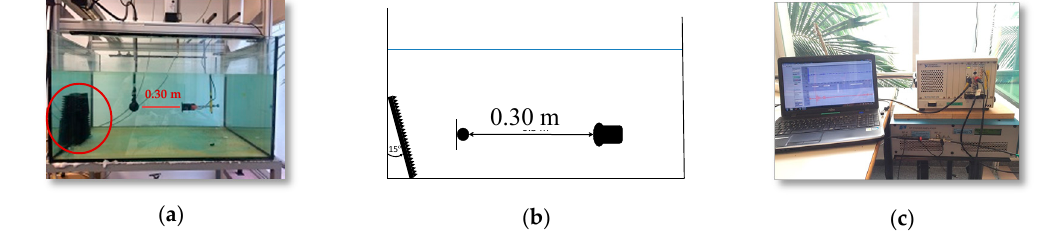
Figure 1. Experimental setup. ( a ) On the right transducer emitter Airmar P19, on the left transducer receiver ITC1032, red circle panel used to avoid critical reflexion; ( b ) arrangement acoustic panel; ( c ) equipment